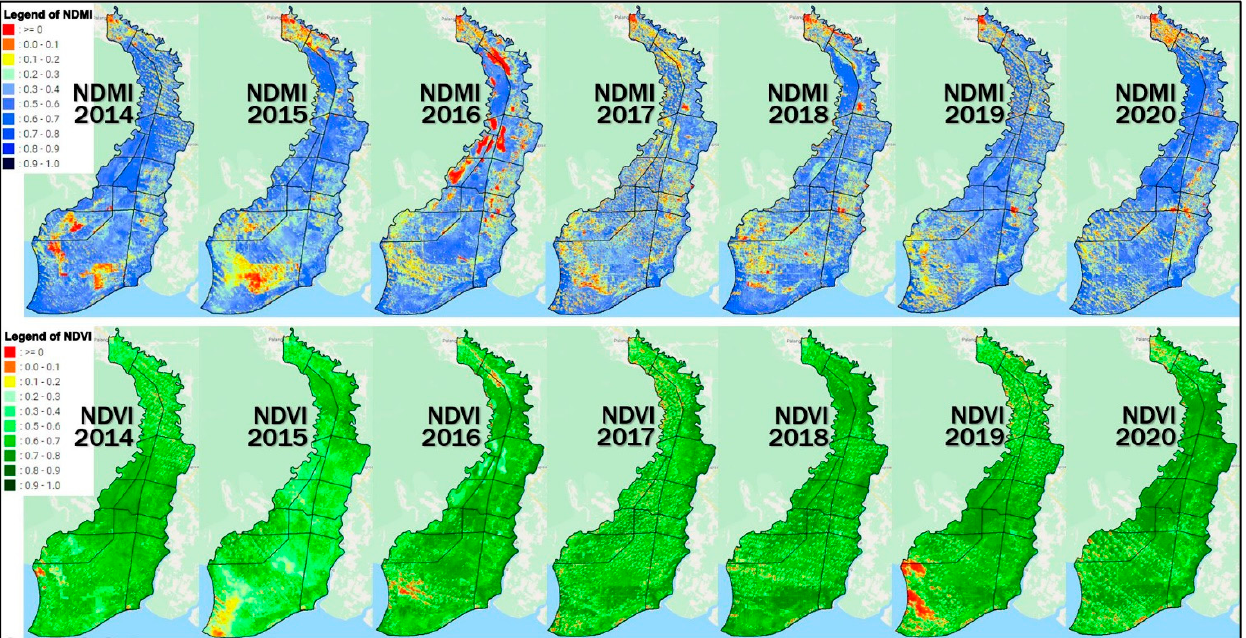
Table 4. Calculation result of average NDMI and NDVI values for each sub-PHU in 2010–2020 (data source: Landsat-8 using Google Earth Engine; processed by the authors). Average Value of NDMI (Moisture) per Sub-PHU